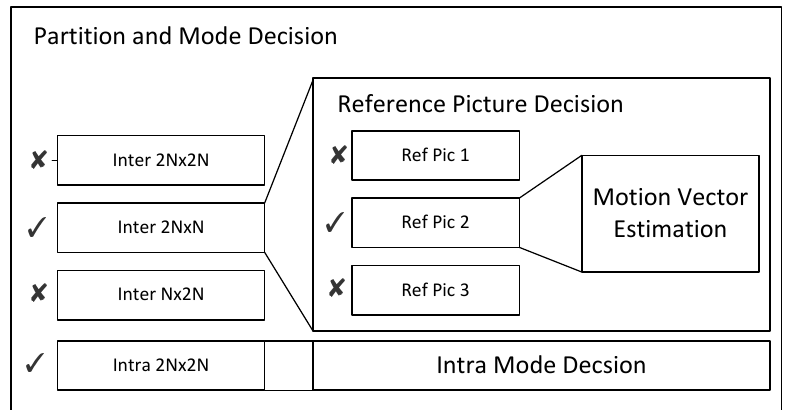
Figure 1. Fast HEVC to AVS2 Transcoding Algorithms Based on Multi-stage Decoding Information Utilization